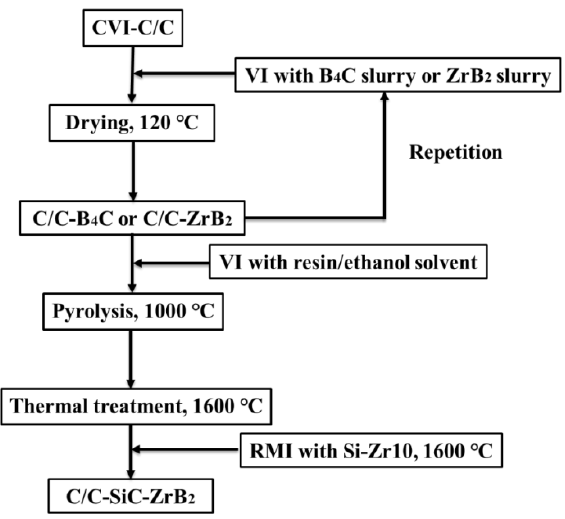
Figure 1. The fabrication procedure of C/C–SiC–ZrB 2 composites.